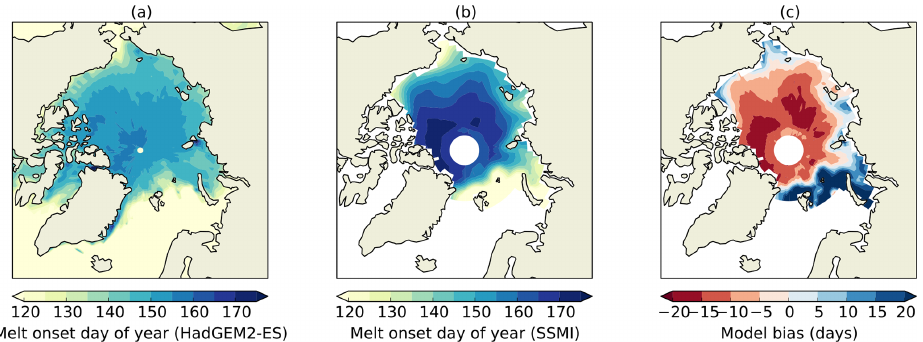
Figure 5. Average date of year of surface melt onset, 1980–1999, (a) as modelled by HadGEM2-ES and (b) as measured by SSMI observa- tions. (c) shows model